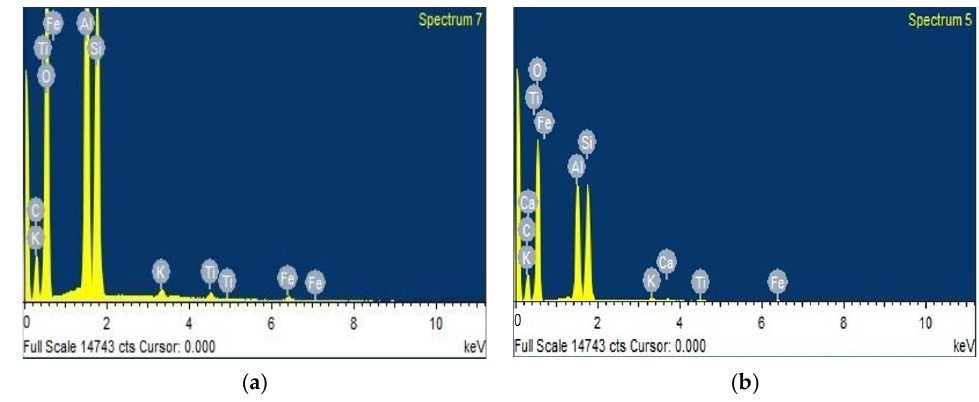
Figure 9. Results of EDS analysis. ( a ) Untreated kaolin; ( b ) β -glucan-treated kaolin.